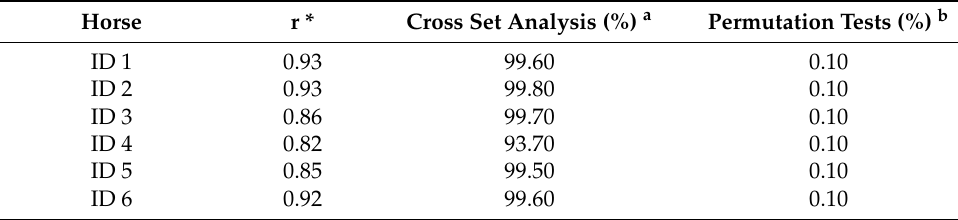
Table 3. Partial least square (PLS) analysis for each individual horse. Horse r * Cross Set Analysis (%) a Permutation Tests (%) b ID 1 0.93 99.60 0.10 ID 2 0.93 99.80 0.10 ID 3 0.86 99.70 0.10 ID 4 0.82 93.70 0.10 0.85 99.50